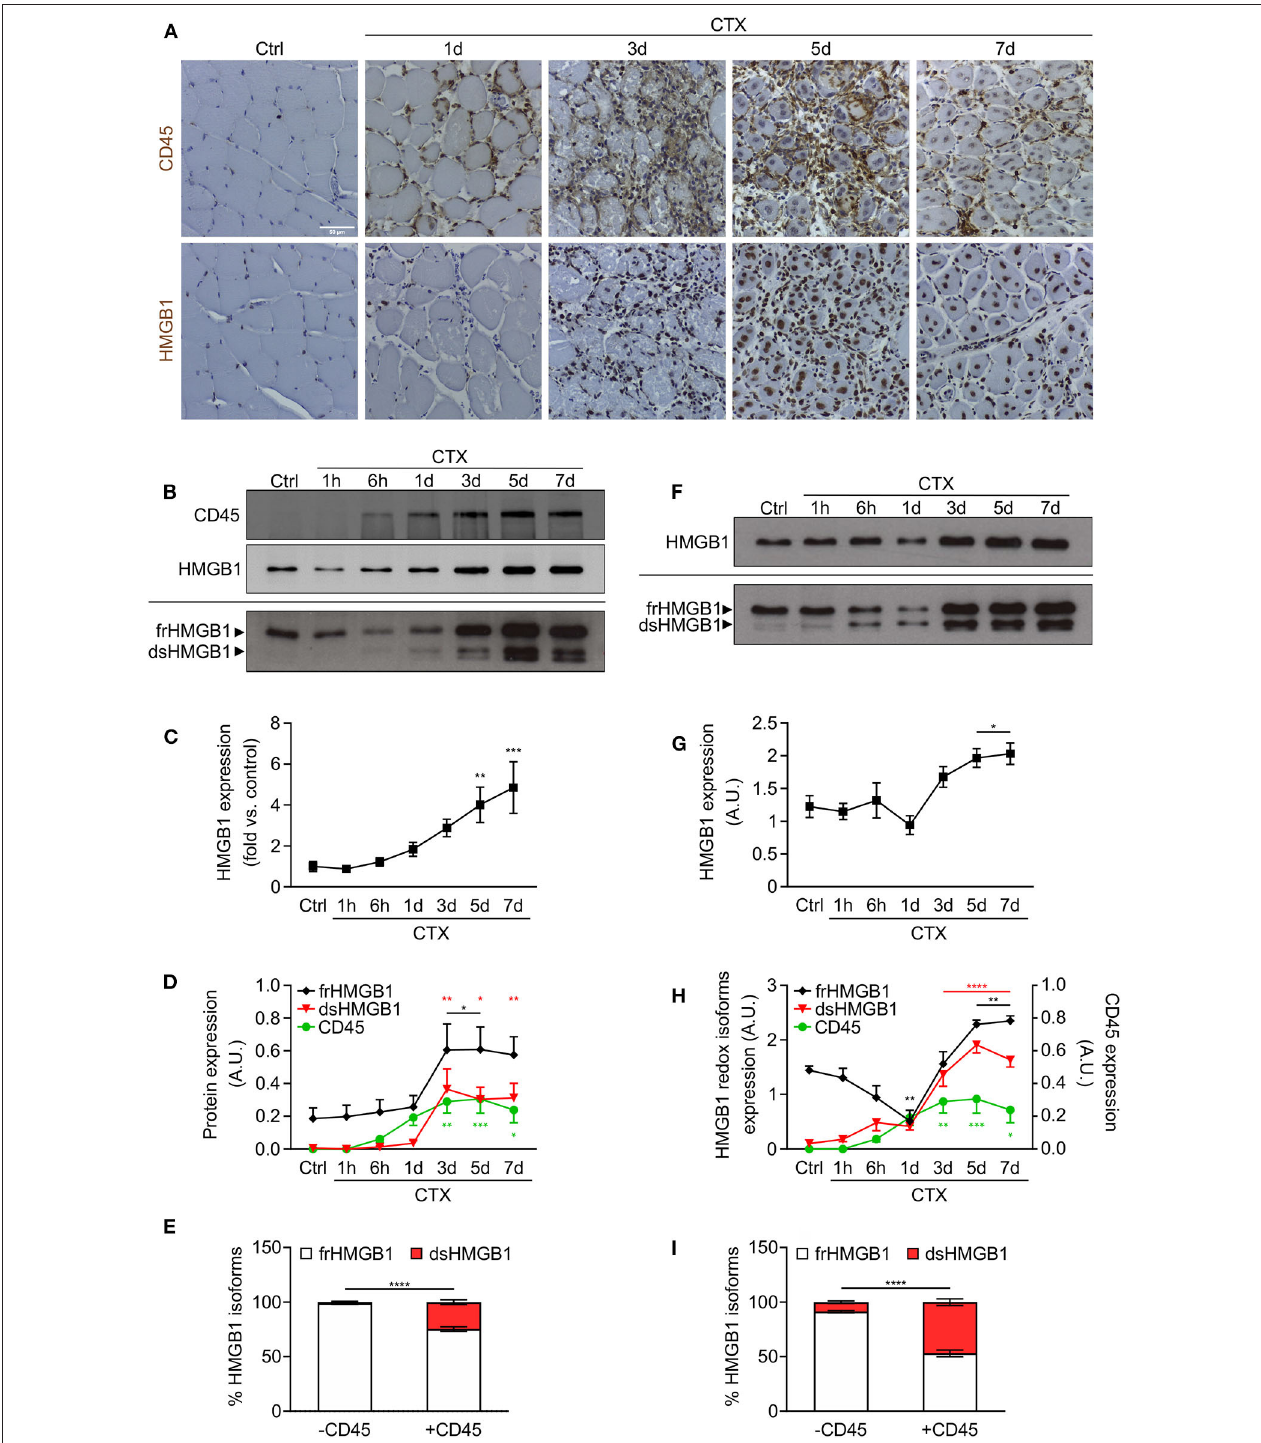
FIGURE 1 | HMGB1 redox isoforms expression and leukocyte infiltration during acute muscle injury. (A) Representative images of immunohistochemical staining for CD45 (upper panel) and HMGB1 (lower panel) on tibialis anterior (TA) muscle sections at indicated time points after cardiotoxin (CTX) injection. Scale bars, 50 µ m. Ctrl, uninjured control muscles. (B–E) Western blot probed with anti-CD45 (upper panel) and anti-HMGB1 (middle panel) antibodies in reducing conditions or with anti-HMGB1 antibody in non-reducing conditions (lower panel) on muscle lysates at indicated time points after CTX injection. The upper and lower bands in non-reducing conditions correspond to the fully reduced-HMGB1 (frHMGB1) and the disulphide-HMGB1 (dsHMGB1) isoforms, respectively. (C) Quantification of